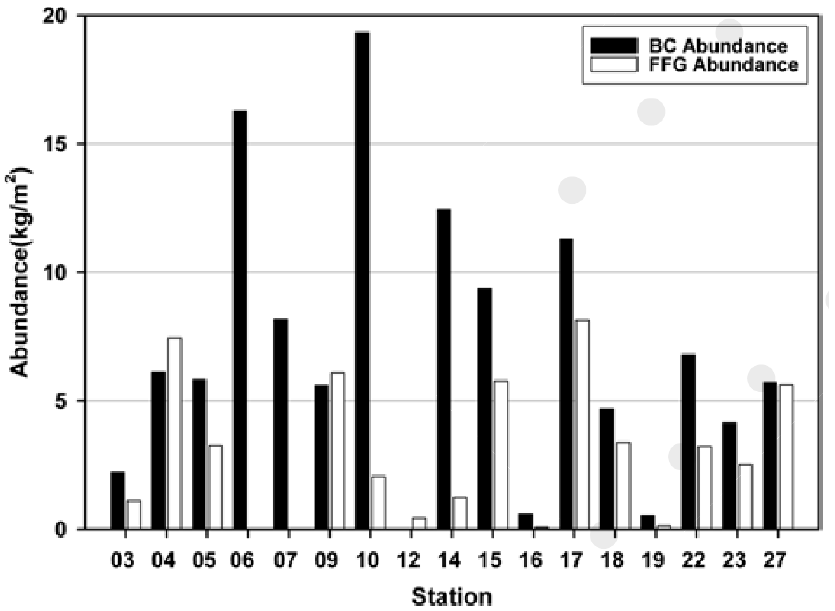
Figure 17. Comparison of returned abundances from BC and FFG at test stations within the KORDI exploration area. Source: Lee et al. [60].